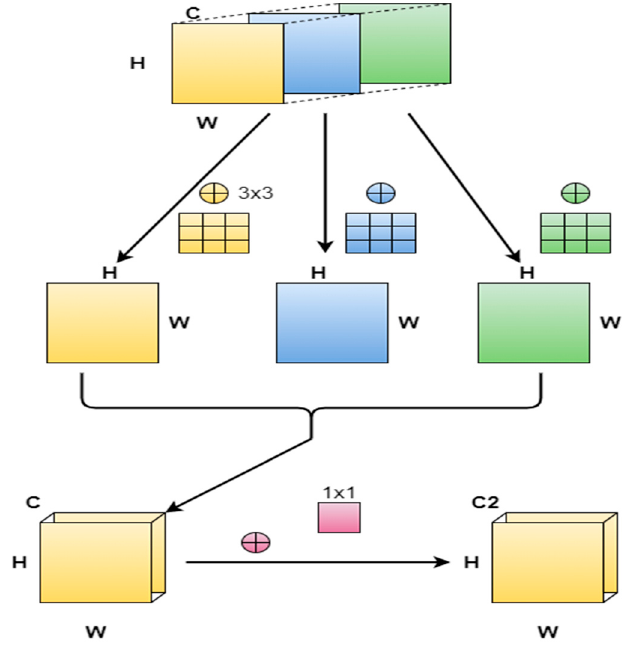
Figure 8. A visual example of Depth-wise separable CNN layer structure.